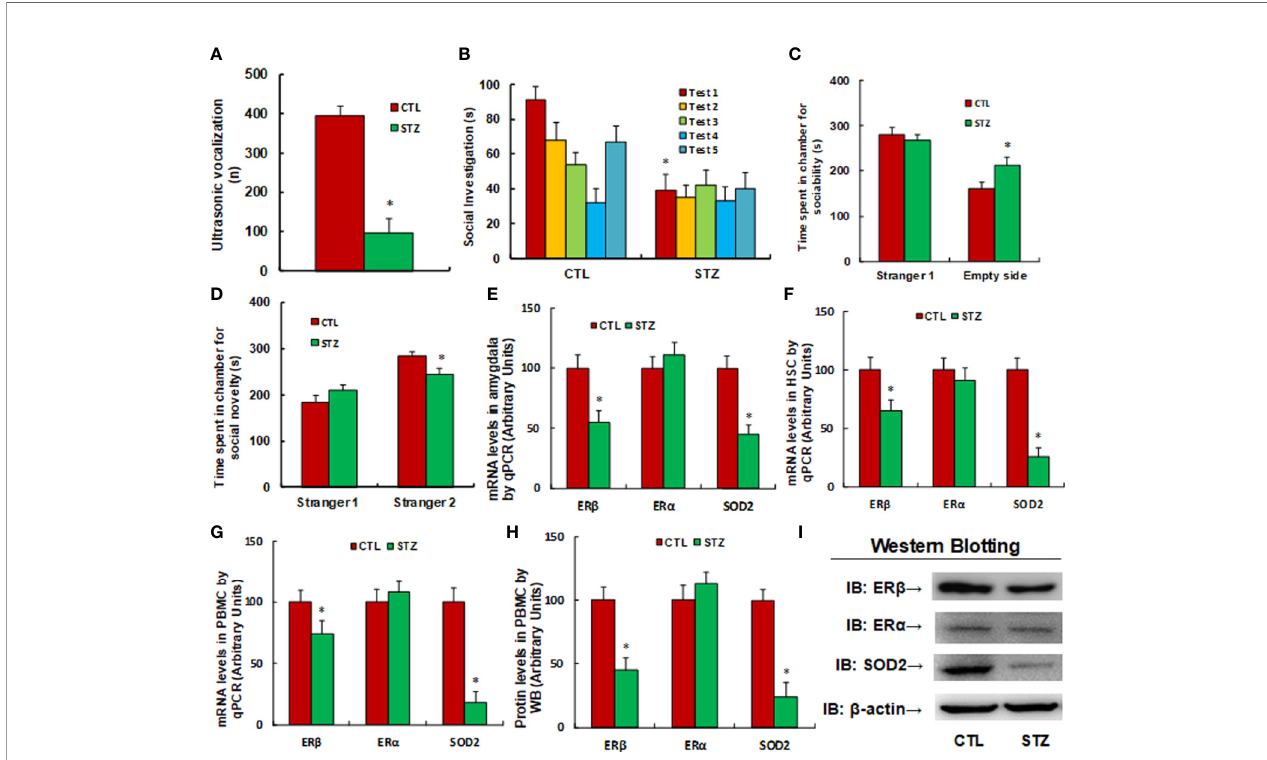
FIGURE 1 | Maternal diabetes induces SOD2/ER b suppression in PBMC in autistic offspring. The 6-week-old male offspring from either the control (CTL) or maternal diabetes (STZ) group were used for analysis. (A – D) Autism-like behavior analysis; (A) Ultrasonic vocalization, n = 9. (B) Social recognition, as indicated through the seconds spent socially investigating a conspeci fi c [same conspeci fi c in tests 1-4; novel conspeci fi c in test 5 (a new stimulus mouse was introduced)], n = 9. (C, D) Three-chambered social tests, n = 8. (C) Time spent in chamber for sociability. (D) Time spent in chamber for social novelty. (E) mRNA levels in the amygdala, n = 5. (F) mRNA levels in HSC, n = 5. (G) mRNA levels in PBMC, n = 5. (H) The protein levels in PBMC, n = 5. (I) The representative pictures of western blotting for (H). * P < 0.05, vs. CTL group. Data were expressed as mean ±